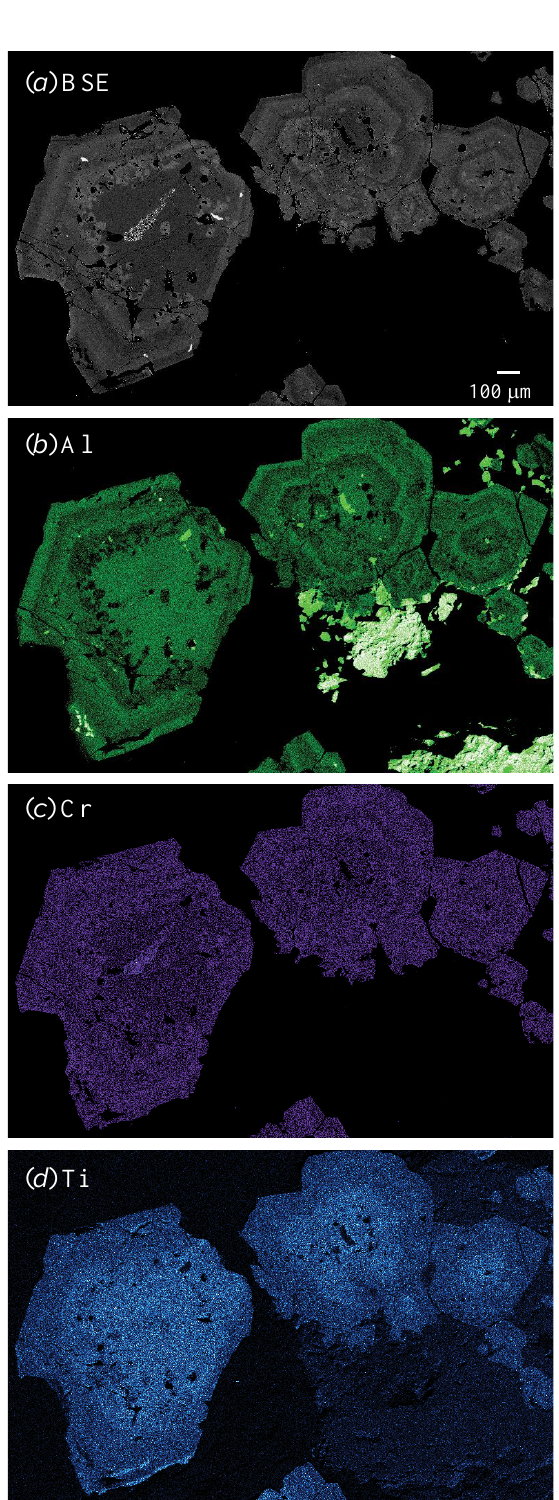
Figure 4. Uv sample 1 from Russia: ( a ) BSE image contains light and dark concentric features that indicate different compositions. The X-ray elemental maps show the distribution of ( b ) Al, ( c ) Cr 3+ , and ( d ) Ti 4+ atoms that occur in the Y site. The Fe 3+ map is homogeneous and is not shown. The concentric features indicate epitaxial growth and two different compositions are observed (Table 2). The scale bar in (a) is 100 μm.